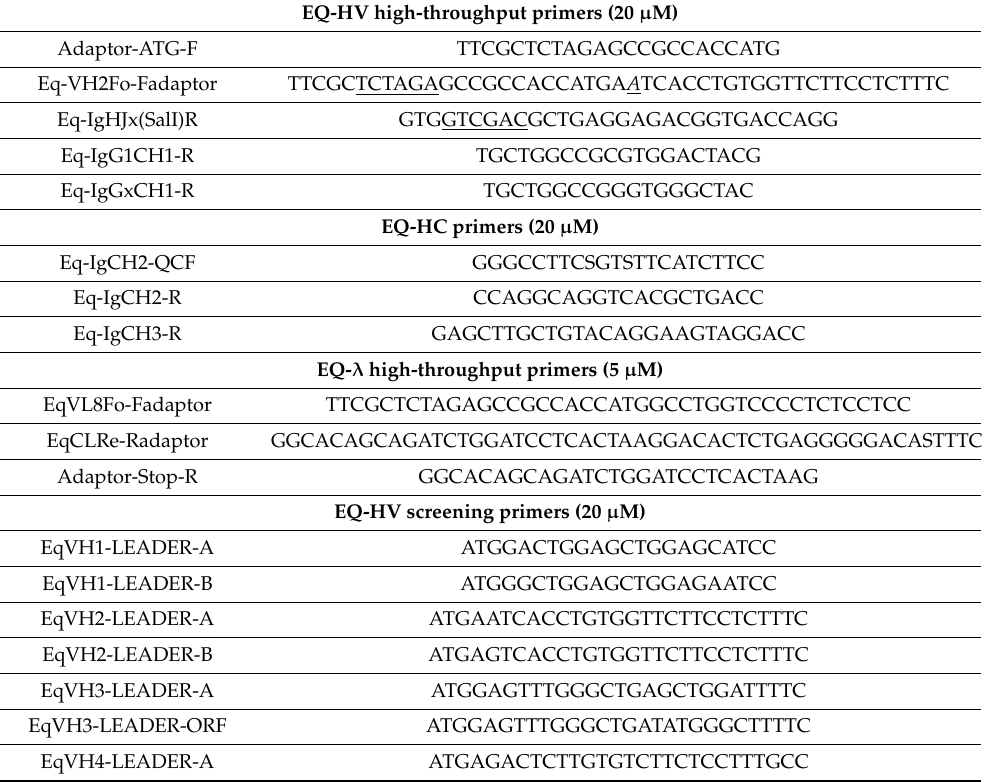
Table 1. Primer sets used for horse antibody discovery